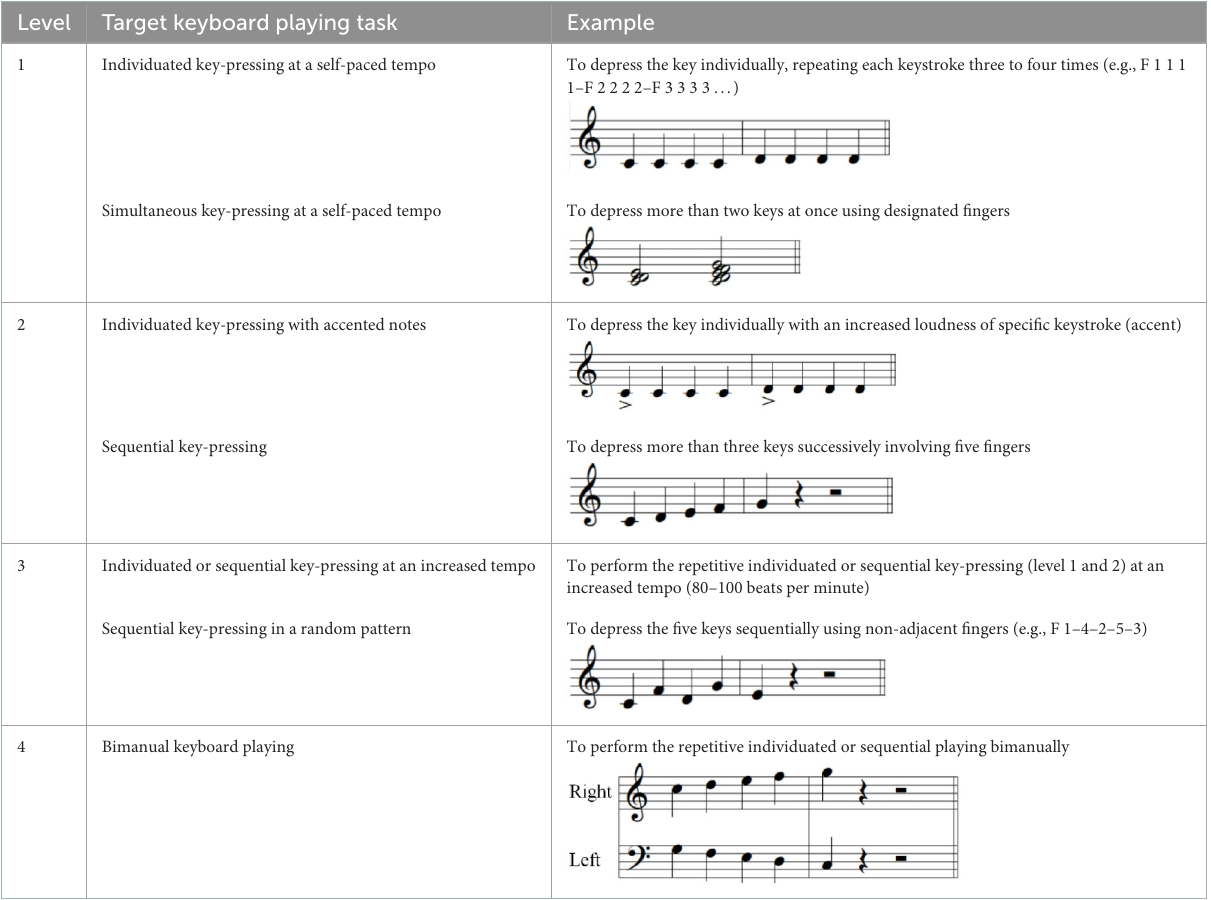
TABLE 2 Target tasks in the movement-specific keyboard playing intervention.